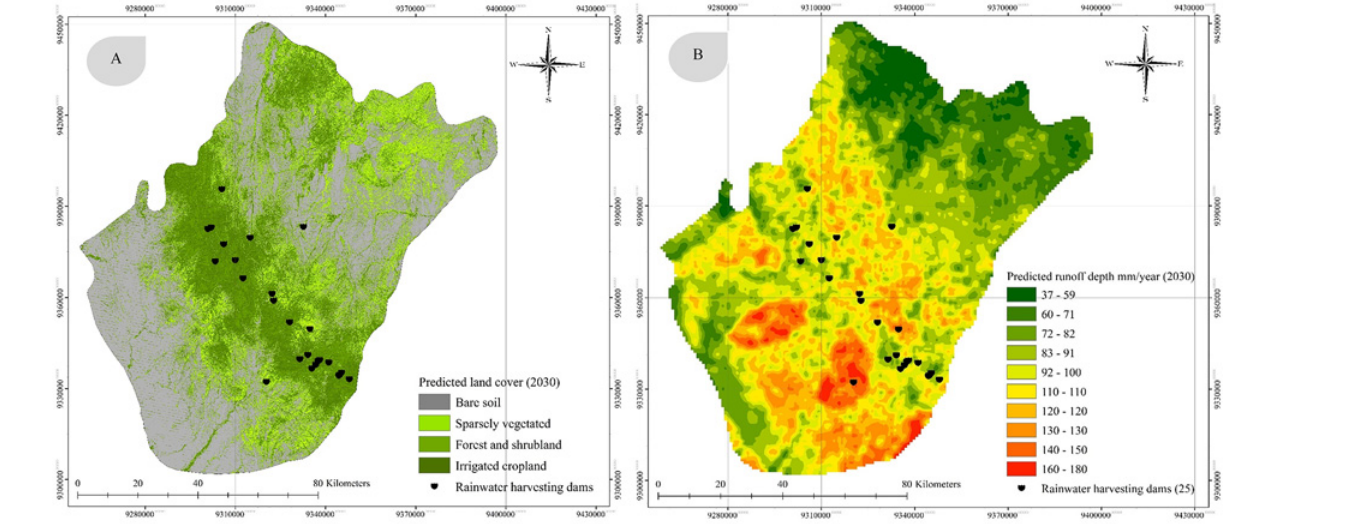
Fig 7. Predicted land cover in 2030 (A) and spatial distribution of the predicted surface runoff depth in 2030